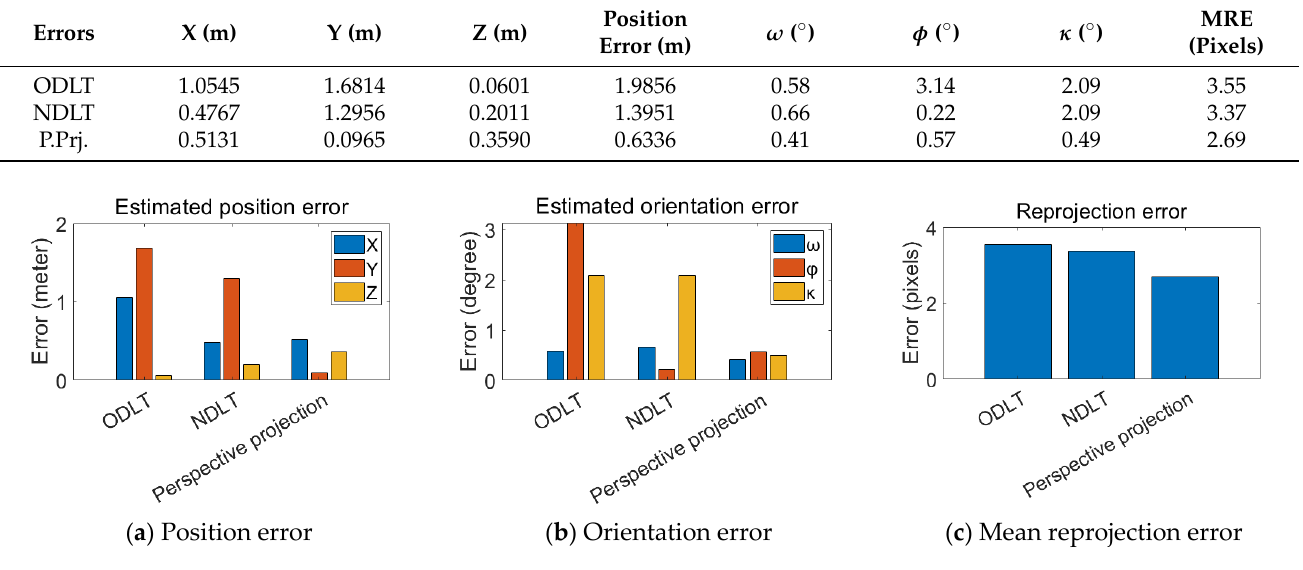
Figure 11. Estimated EOPs error ( a , b ) and mean reprojection error ( c ) for CCTV.